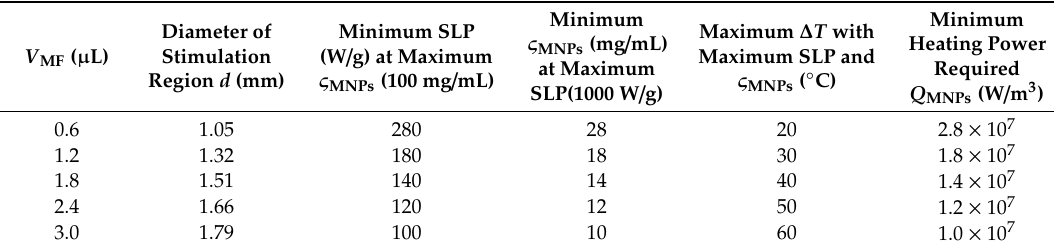
Figure 1. Steady-state temperature change derived from Fourier’s law as a function of specific loss power (SLP), concentration ( ς MNPs ) and volume ( V MF ) of magnetic nanoparticles (MNPs). Conditions that satisfy the temperature increase ∆ T > 6 ◦ C lie above the green plane ( ∆ T = 6 ◦ C). ( a ) All the di ff erent values of V MF ; ( b ) V MF = 0.6 µ L; ( c ) V MF = 1.2 µ L; ( d ) V MF = 1.8 µ L; ( e ) V MF = 2.4 µ L; and ( f ) V MF = 3.0 µ L. Table 1. The minimum amount of SLP, ς MNPs and heating power Q MNPs values required for WMS for di ff erent values of V MF without considering blood flow (BF) and cerebrospinal fluid (CSF), determined using Fourier’s